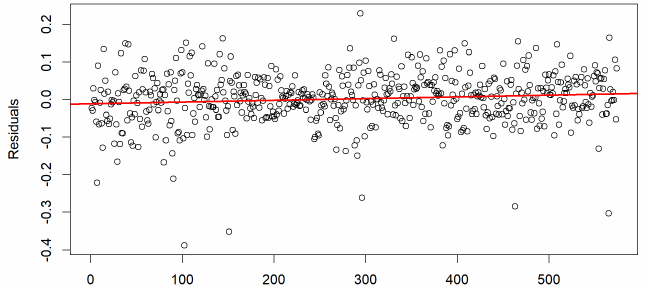
Figure 10. Regression Plot for the Log − Differenced Residual Distribution.